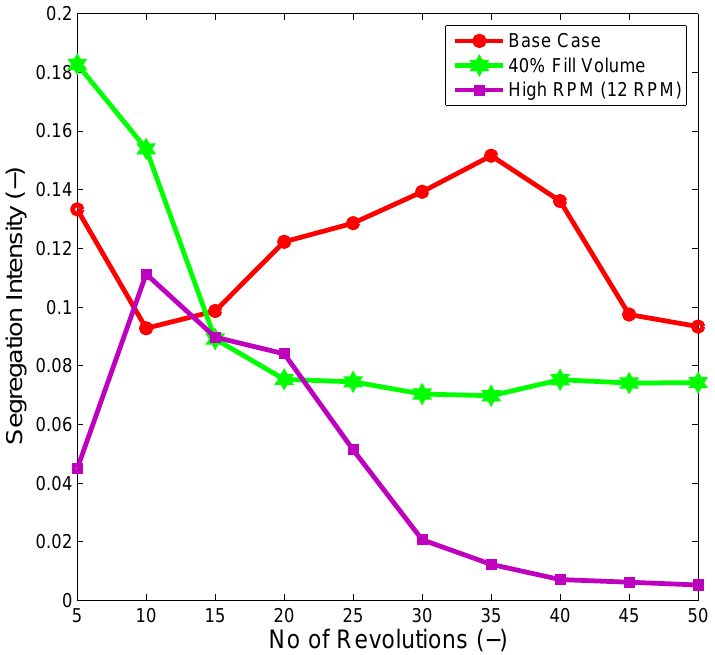
Figure 10. Variation of the segregation intensity of the extra granular phase with the change in processing